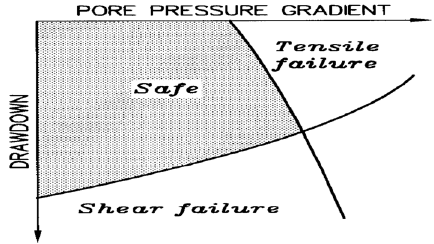
Fig. 1 Stability diagram for production cavities as reported by (Morita et al. 1987a, b: